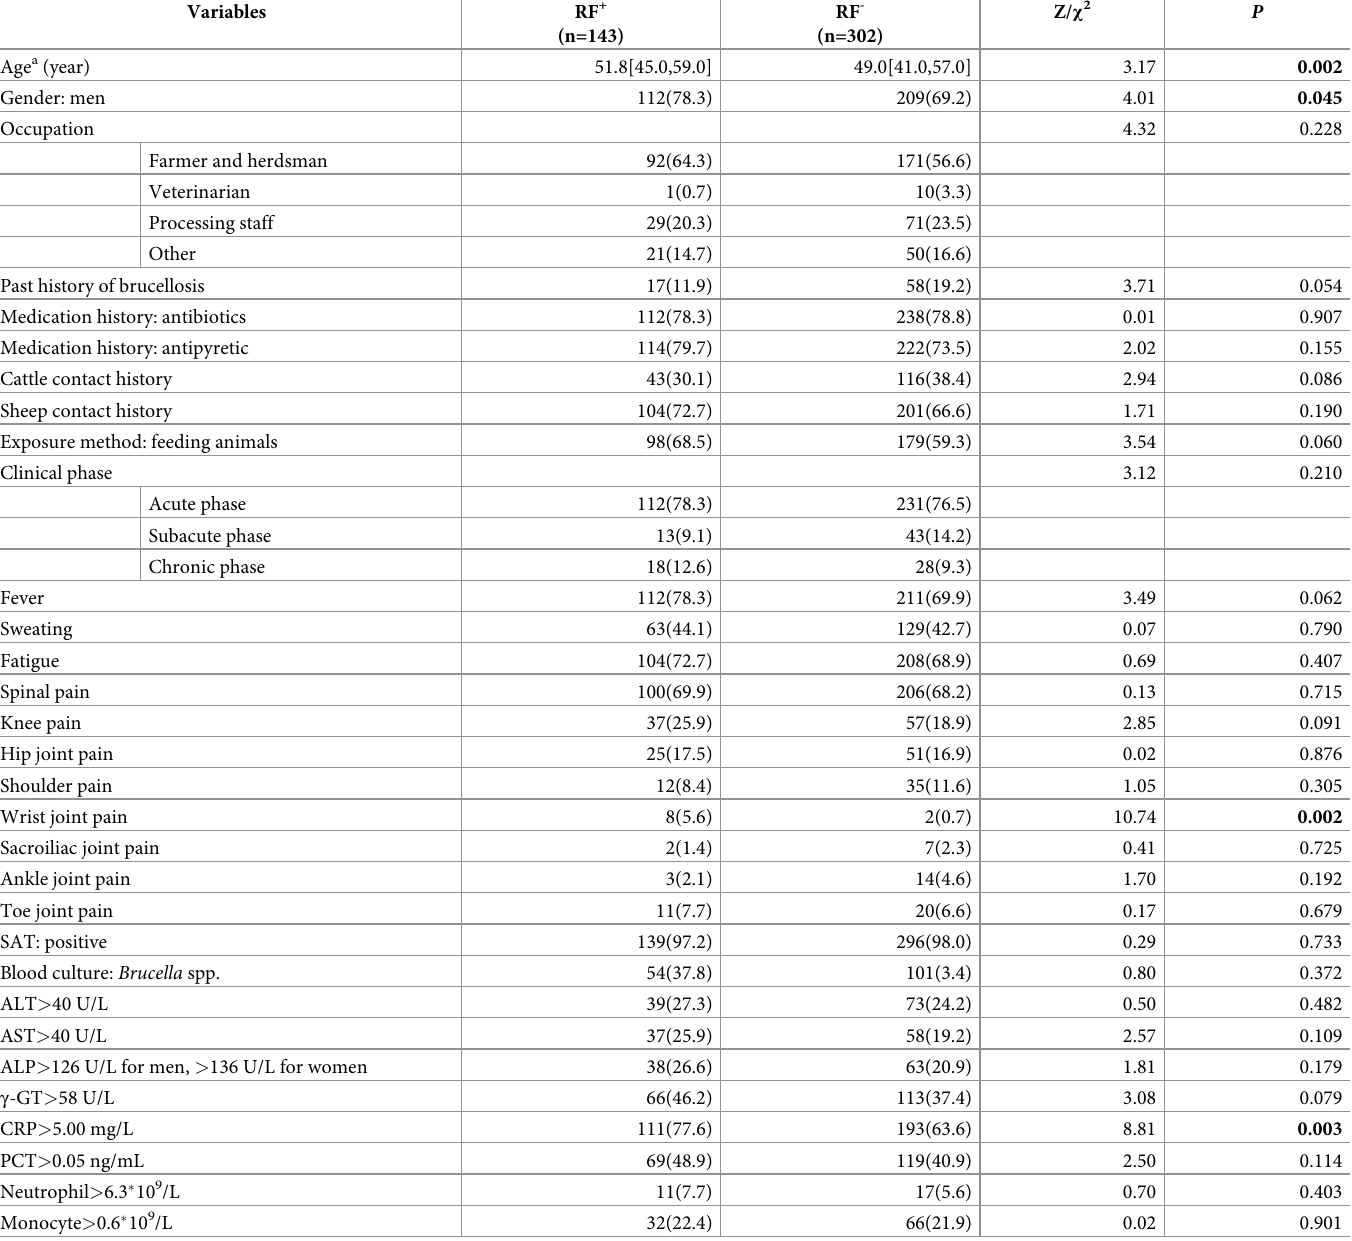
Table 4. Comparison of general characteristics in 445 brucellosis patients with arthralgia by RF level.